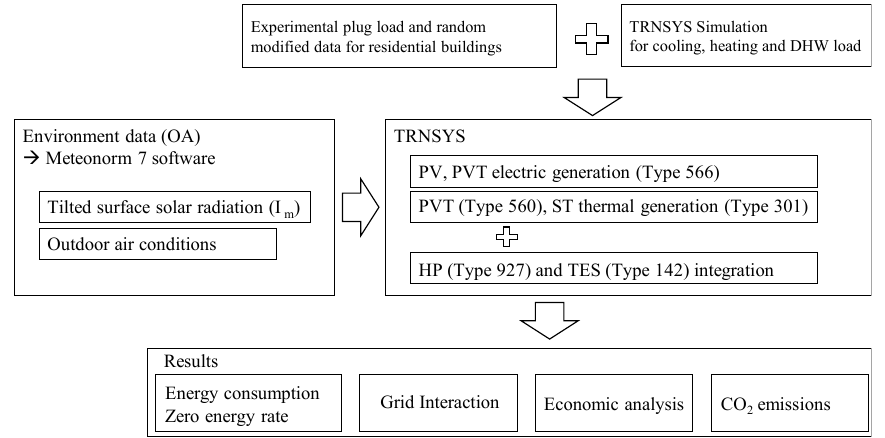
Figure 4. Overview of the simulation method.